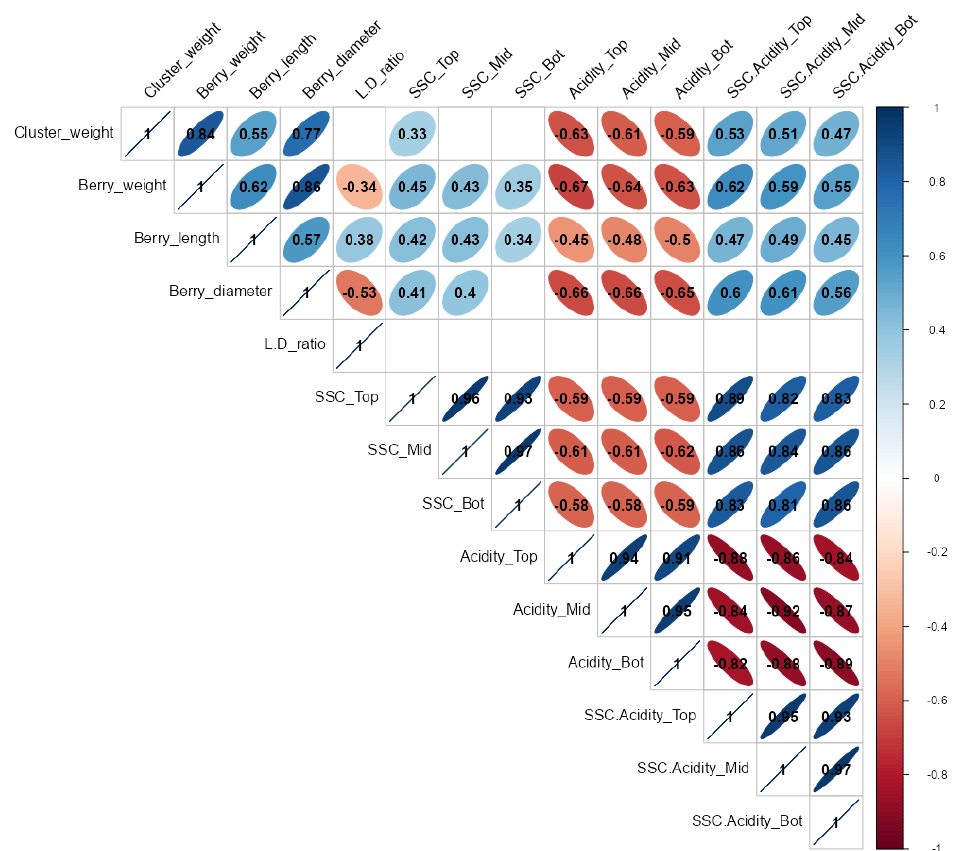
Figure 3. Heatmap matrix of Pearson’s correlation coefficient ( r ) among the fruit qualities of ‘Shine Muscat’ according to plant growth regulator treatments. (n = 60/12 samples × 5 treatment).